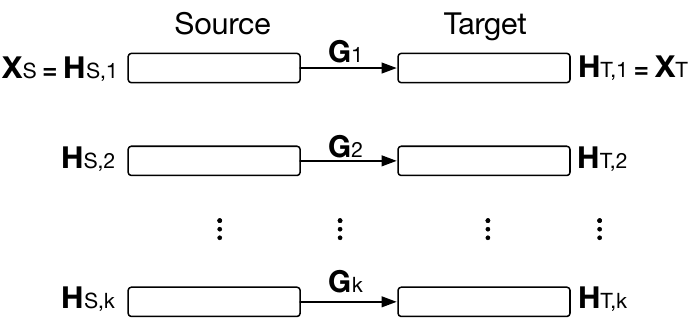
Figure 3. HHTL for transferring hidden representations, H , between source and target domain. H are extracted from trained